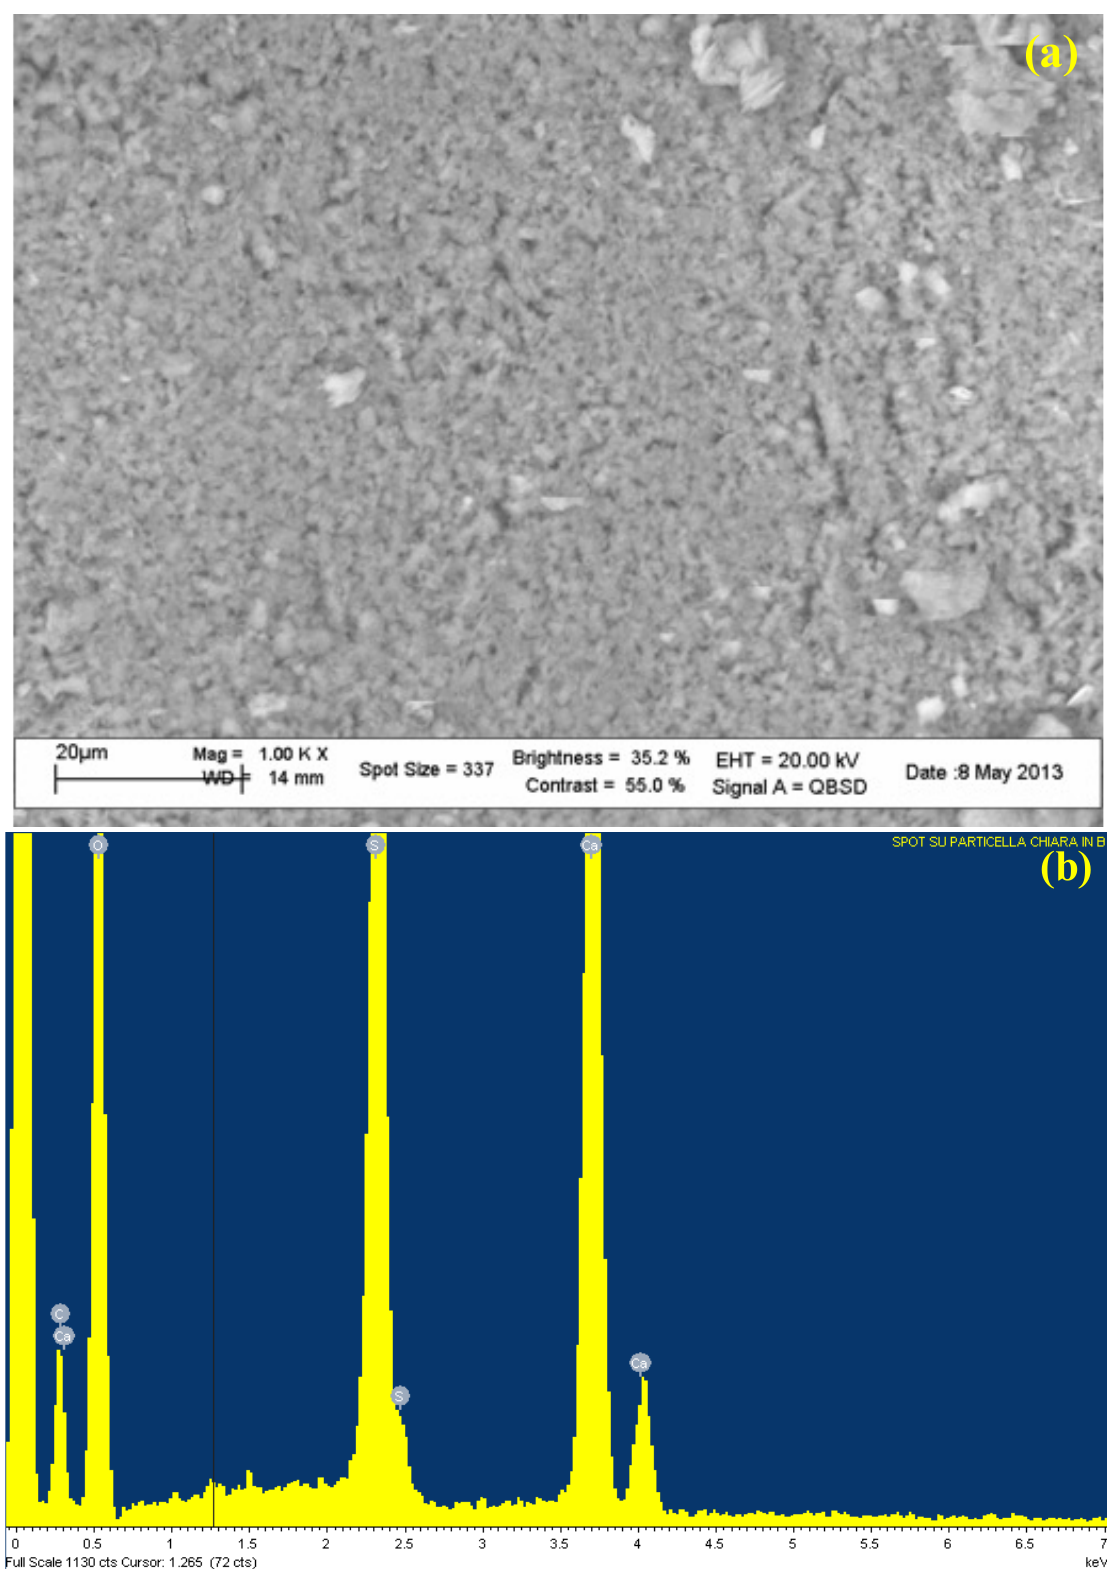
Figure 6. SEM photo ( a ) and EDS spectrum ( b ) of the spot of the particle “A” of the wall sample. For experimental condition: see Section 4 (Materials and Methods).